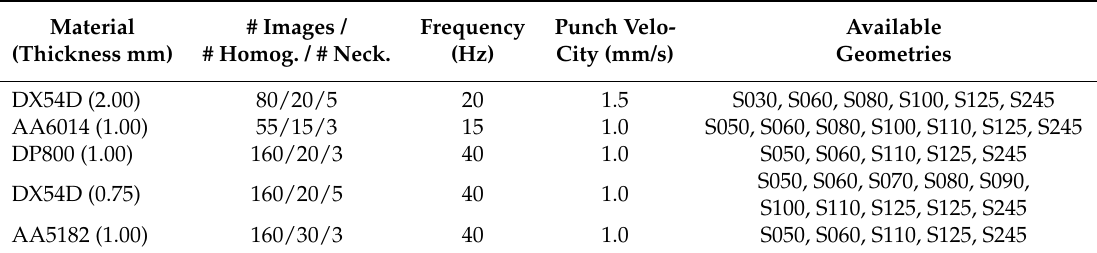
Table 2. Database per material with process